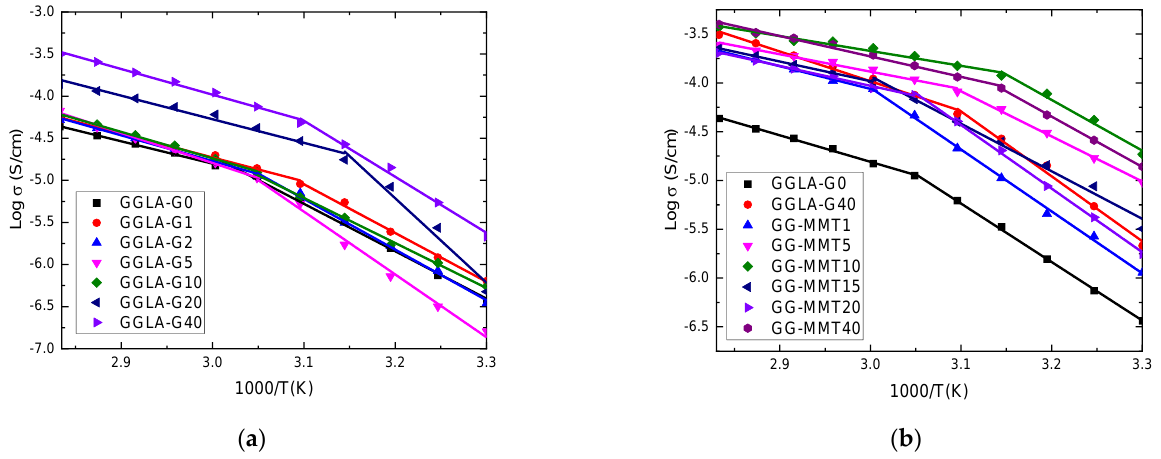
Figure 2. Log of ionic conductivity as a function of the inverse temperature of GGLA-based SPEs ( a ) and GGLA-G0, GGLA-G40 and GG-MMT-based NPEs ( b ) with different amounts of LiClO 4 .